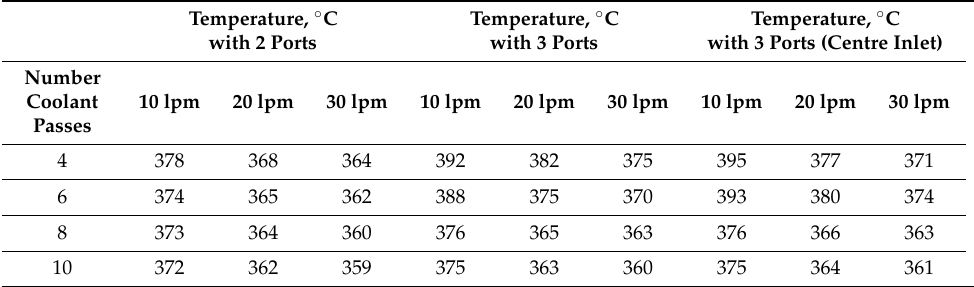
Figure 9. Port configuration [40]. Table 6. Maximum temperature versus flow rate for all the designed models [40].